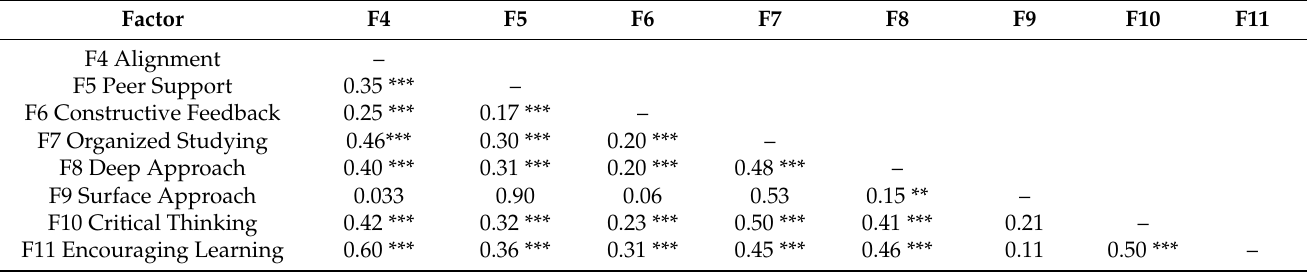
Table 3. Correlations between factors in the Teaching and Learning Experiences Questionnaire (ETLQ) model by Utriainen et al. (2018)